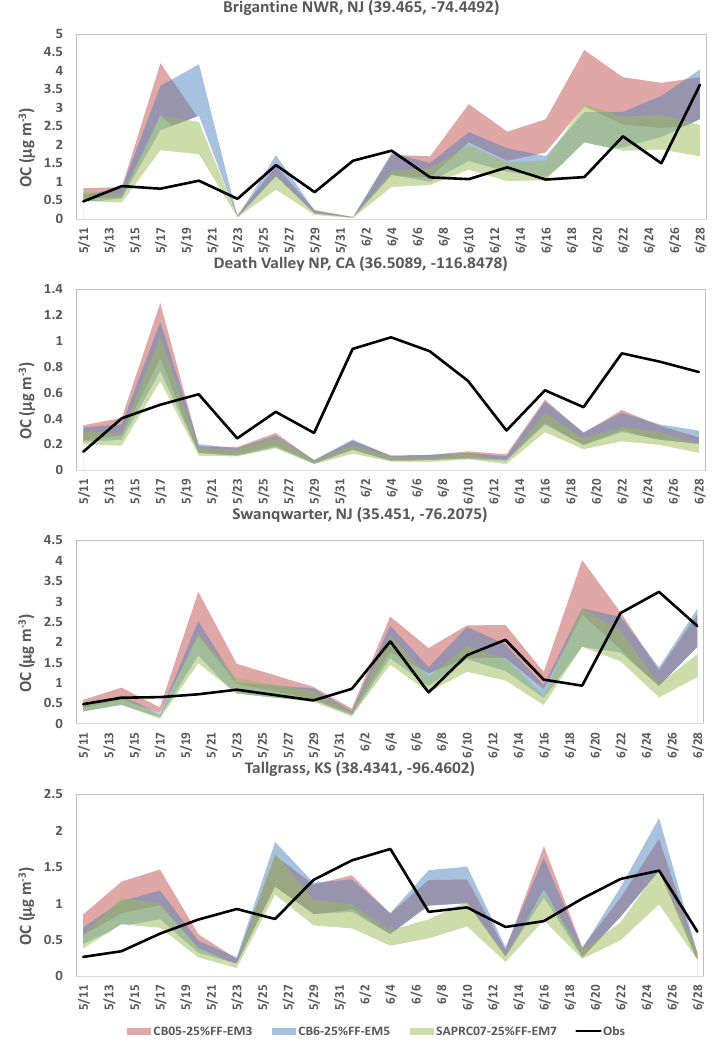
Figure 7. Time-series plots of IMPROVE OC vs. simulated OC at selected sites from sensitivity simulations of different gas-phase mecha- nisms. The colored bands represent the range of OC values for ratios 1.4 to